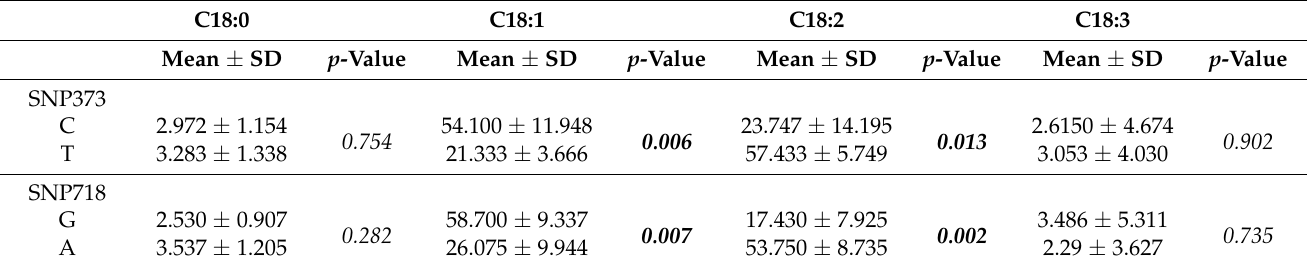
Table 4. Association between predicted SNPs (SNP373 and SNP718) and the composition of fatty acids for the studied vegetable oils.